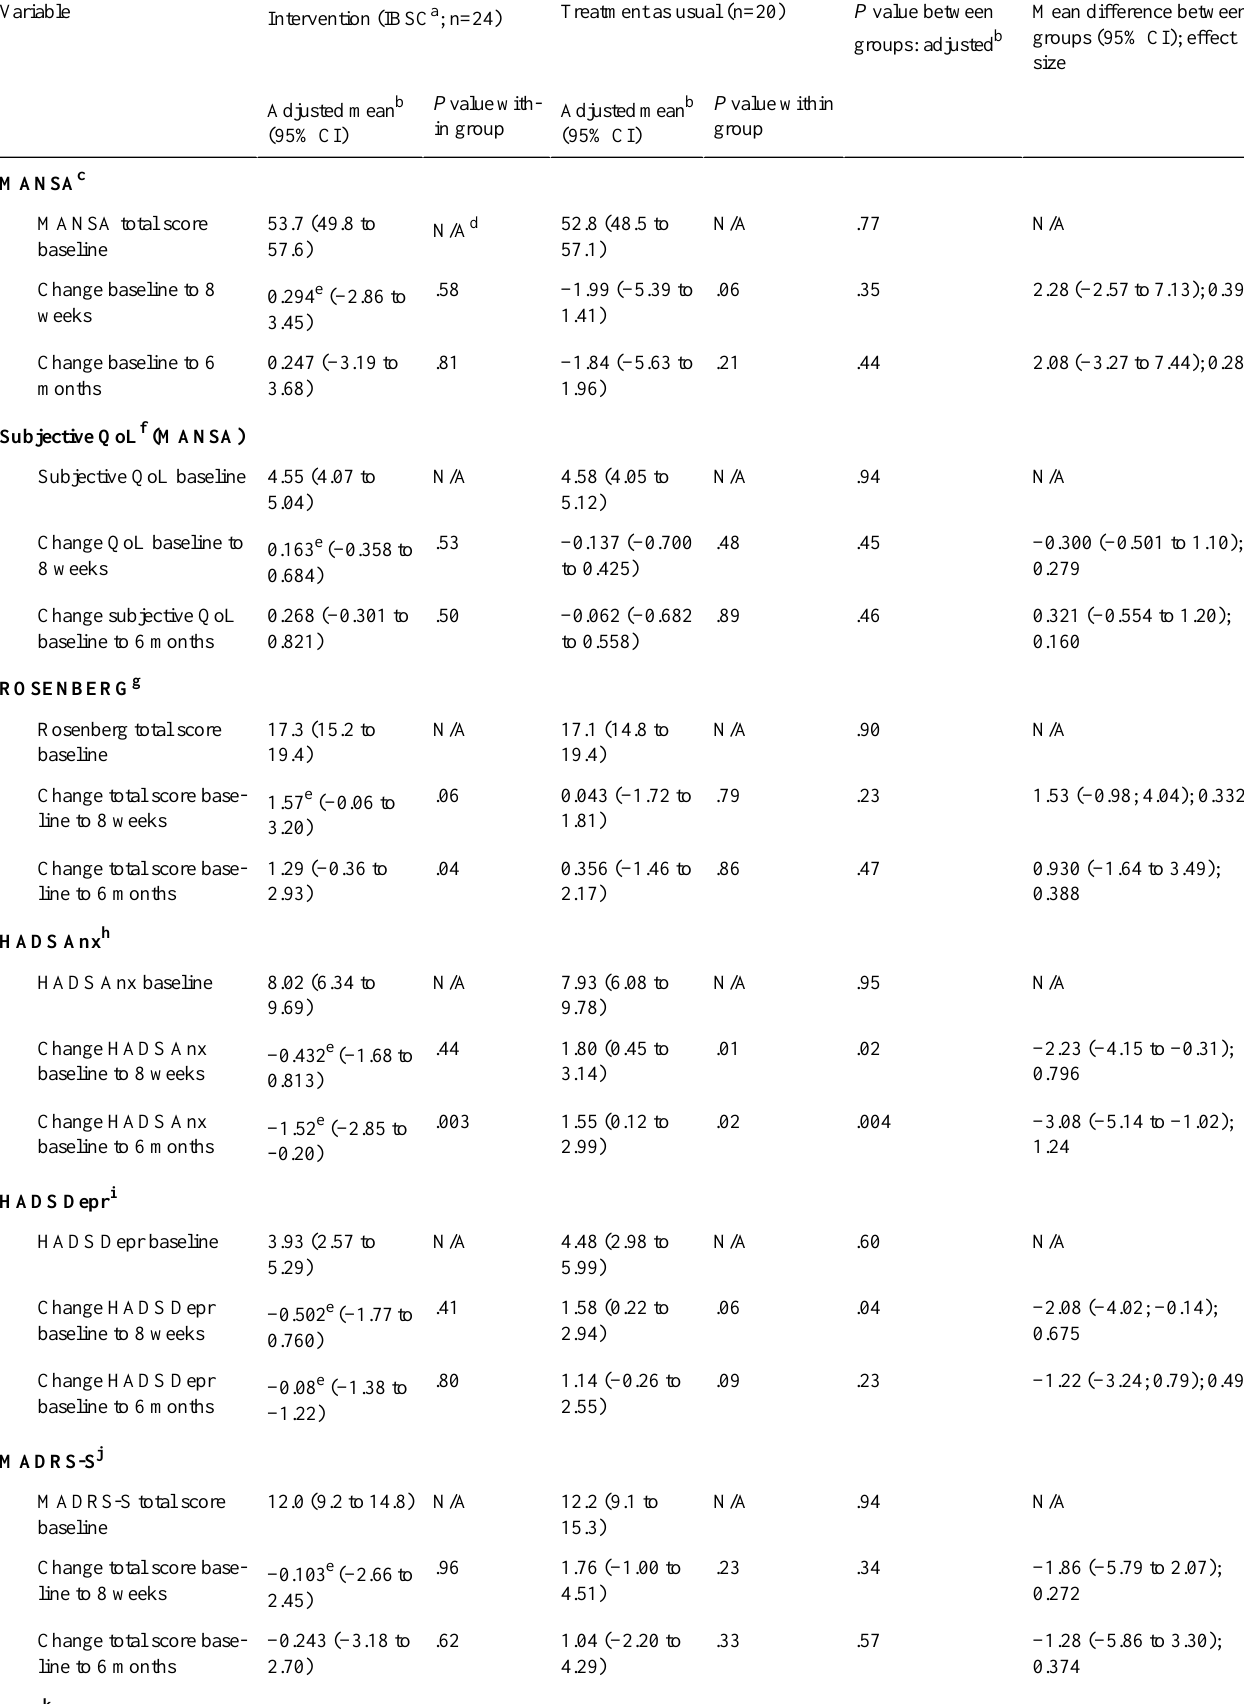
Table 2. Adjusted primary and secondary variables at baseline, after 8 weeks, and 6 months by treatment